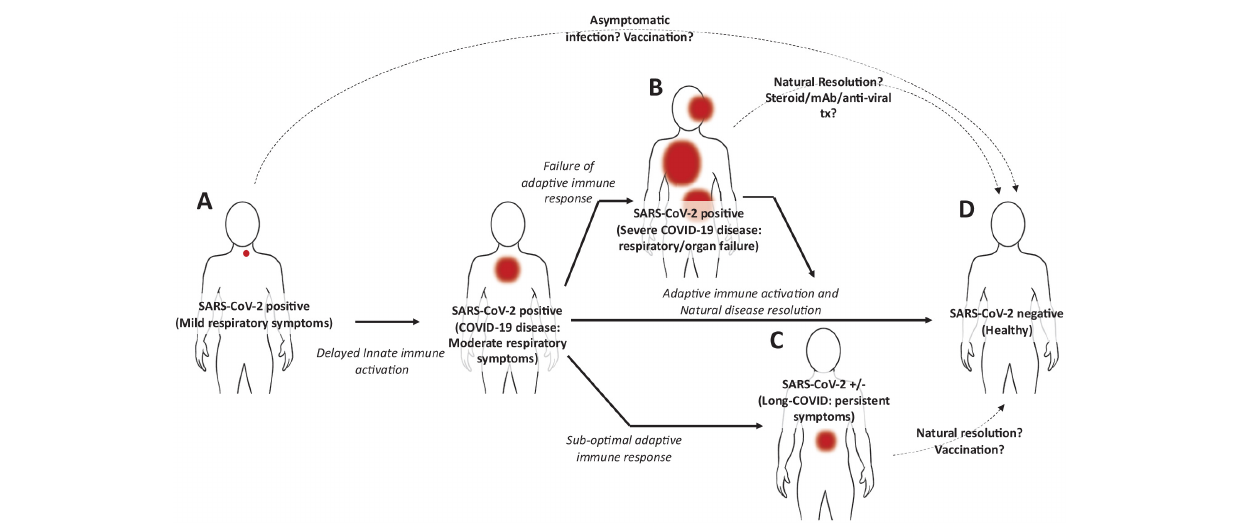
FIGURE 1 | Hypothetical model of SARS-CoV-2 infection and disease progression. (A) Following initial infection in the upper pulmonary tract, the SARS-CoV-2 virus evades type I IFNs, delaying innate immune activation. Progressively, respiratory symptoms increase (COVID-19 disease) along with viral load, however, the adaptive immune response against the virus, including T cells and B cells is becoming activated. (B) Among individuals unable to induce an effective adaptive immune response to the virus, the innate immune system is aberrantly activated and the virus spreads. In severe cases this can result in pulmonary and organ failure requiring hospitalisation. While this can be fatal, some individuals can recover either untreated or following treatment with steroids, anti-SARS-CoV-2 monoclonal antibodies, and antiviral medications. In these cases it is possible that incomplete viral clearance might also result in Long-COVID. (C) In around 10% of individuals who do recover from COVID-19 disease and whose acute symptoms associated with pulmonary disease resolve, a cluster of symptoms can persist including fever, diarrhoea, headaches, and even anxiety and depression. (D) Most individuals recover from COVID-19 without lingering symptoms. This likely reflects the induction of an effective adaptive immune response, potentially resulting in immunological memory. Red spots indicate sites and severity of infection. Dotted lines indicate method of disease resolution or